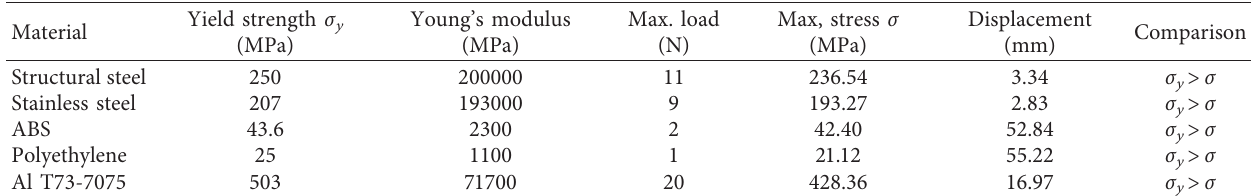
Table 2: Failure analysis of the TLET joint with various materials.